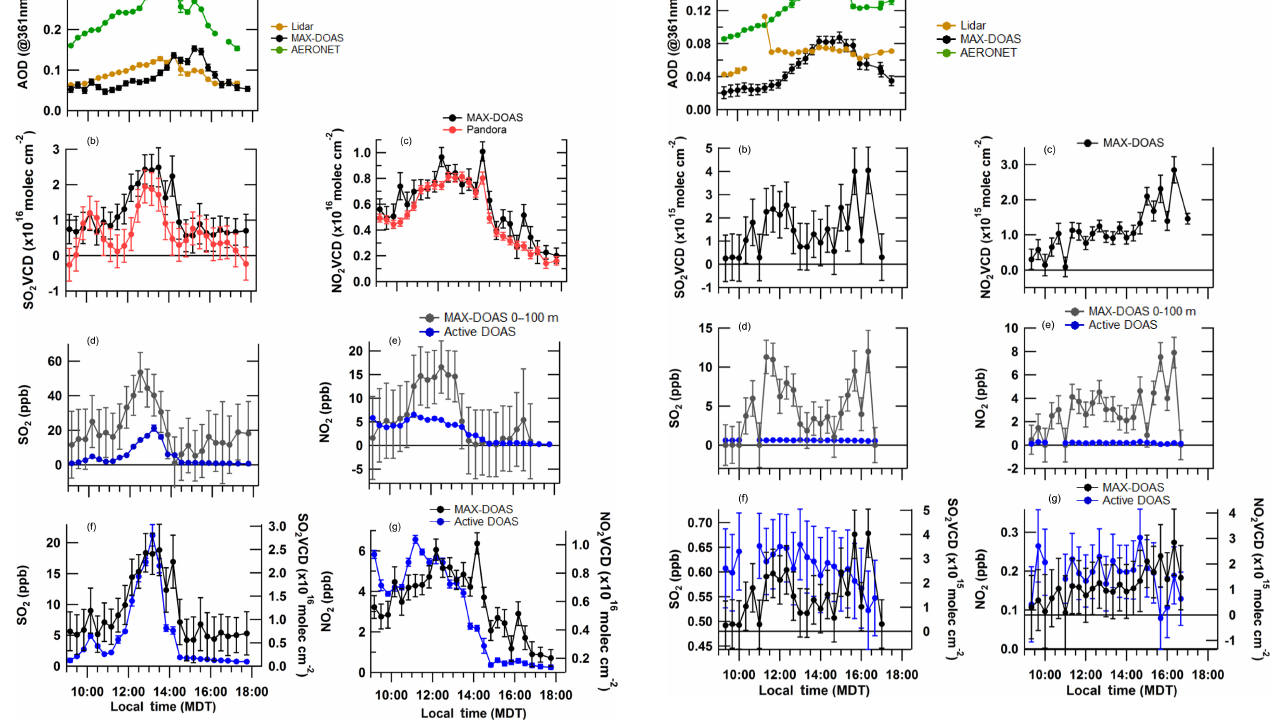
Figure 6. The 4 September AODs from MAX-DOAS, lidar, and AERONET (a) ; MAX-DOAS and Pandora SO 2 VCDs (b) ; MAX- DOAS and Pandora NO 2 VCDs (c) ; MAX-DOAS 0–100m and ac- tive DOAS SO 2 mixing ratios (d) ; MAX-DOAS 0–100m and ac- tive DOAS NO 2 mixing ratios (e) ; MAX-DOAS VCDs and active DOAS mixing ratios of SO 2 (f) ; and MAX-DOAS VCDs and ac- tive DOAS mixing ratios of NO 2 (g) . MAX-DOAS error bars were obtained from the optimal estimation retrieval. Error bars on the li- dar and AERONET AODs are the standard error of the temporally averaged values. Error bars on the Pandora VCDs and active DOAS mixing ratios are root-sum-square errors of the standard error from averaging and instrumental precision and the DOASIS retrieval er- ror, respectively. See Sect. 2.3.3 for details.